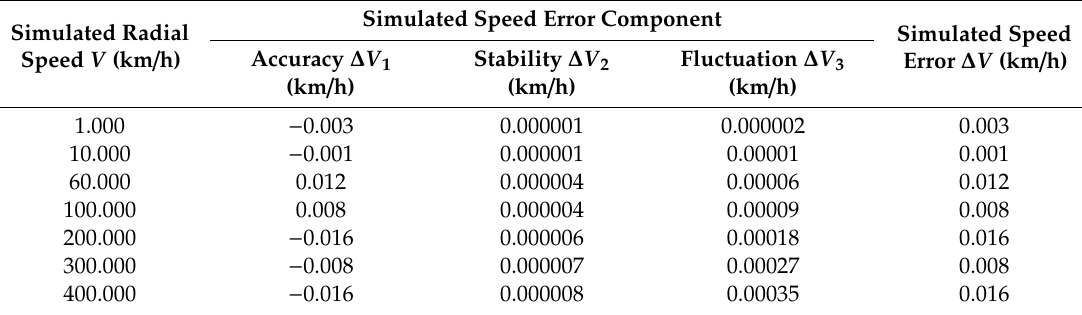
Table 8. Simulated speed error of the first moving target simulator.